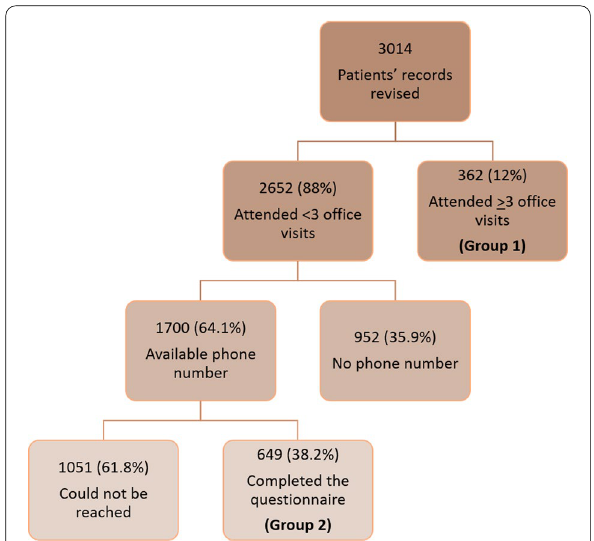
Fig. 1 Flow chart demonstrating the inclusion of patients in the